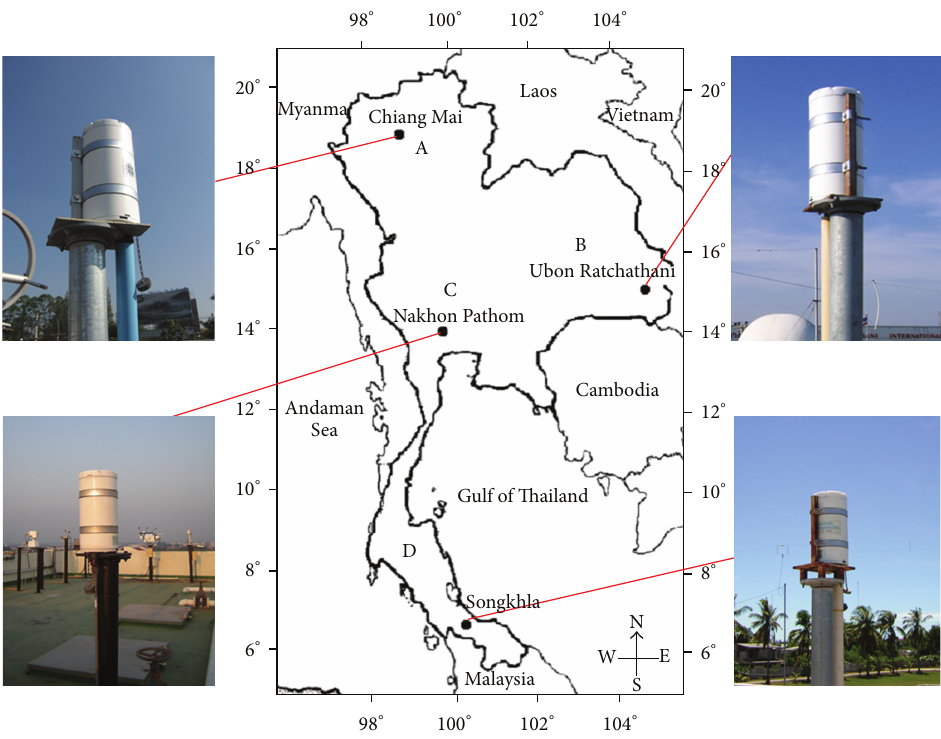
Figure 2: GUV radiometers and locations of the measuring stations. A, B, C, and D indicate the main regions of Thailand, namely, northern region, northeastern region, central region, and southern region,